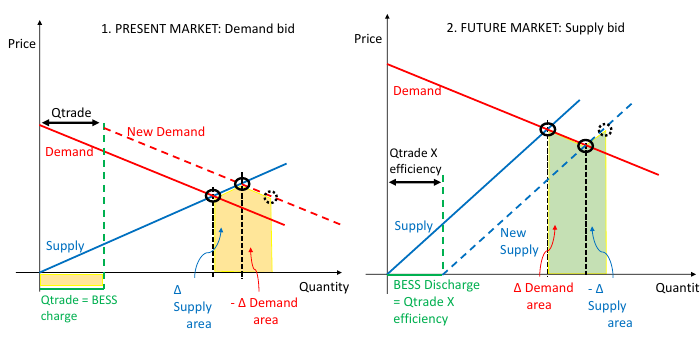
Figure 4. Evaluation of a demand bid in the present and supply bid in the future